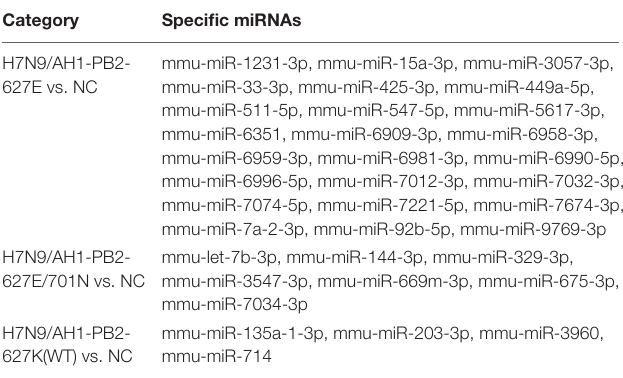
TABLE 2 | Specific upregulated miRNAs in lung tissues of mice induced by H7N9/AH1-PB2-627K(WT) and its mutant viruses. Category